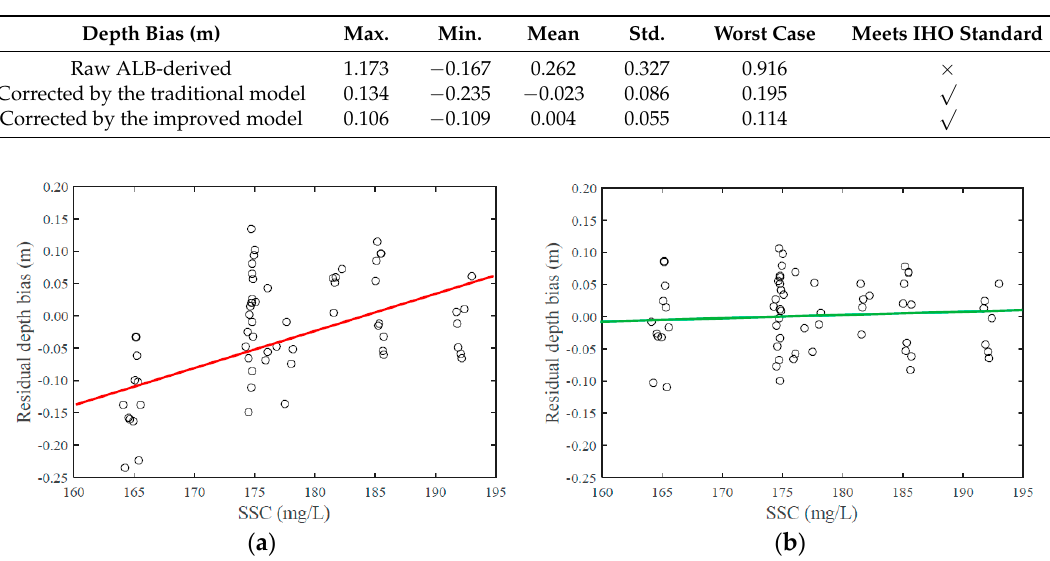
Table 6. Statistical parameters of the depth biases: raw ALB-derived, corrected by the traditional depth bias model, and corrected by the improved depth bias model.